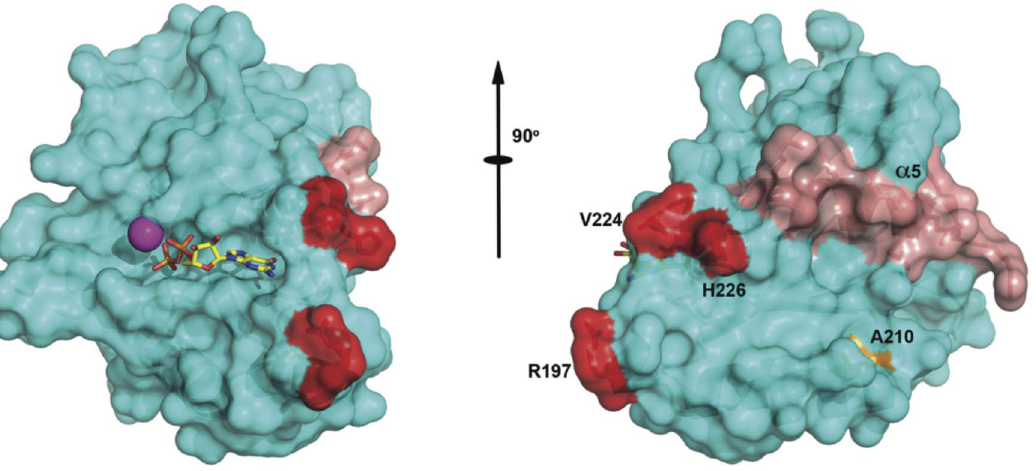
Figure 6. Location of RGK protein structural determinants. Shown are two perspectives, related by a 90 u rotation along the drawn axis, of the RGK G-domain in surface representation. Secondary structure is depicted along with labeled residues underneath the surface. Nucleotide (GDP) is shown in a bond representation and Mg 2 + is seen as a magenta sphere. The red residues are the amino acids essential for RGK-Ca V b association as denoted by inverted black triangles in Figure 4. Alpha helix 5 is shown in pink and the absolutely conserved Ala from alpha helix 4 is shown in orange. Residue numbering is based on Homo sapiens Gem (PDB code: 2HT6).